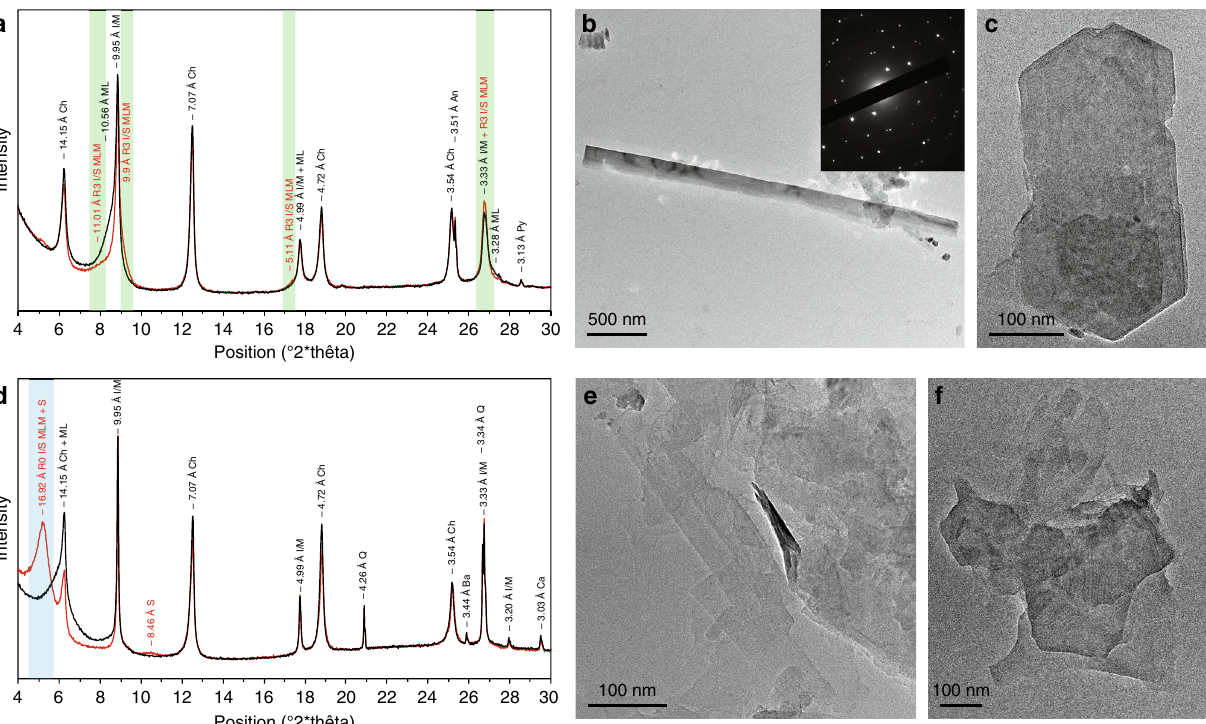
Fig. 5 Mineralogical composition of the <2 µ m clay-size fractions. X-ray diffraction pro fi les of oriented preparations after air-drying (black lines) and glycolation (red lines) and their transmission-electron images are given. a Microbial mat specimen. b Large, well-crystallized lath from microbial mat laminae. The inset shows selected area electron diffraction (SAED) pattern. hk 0 pattern shows a hexagonal structure typical of phyllosilicates and coherently stacked crystals. c Hexagonal habit of illite from a mat sample. d Associated sandstone sediment. e Lathlike and poorly crystallized particles from the host sandstone. f Tiny hexagonal-shaped particles from the host sediment. [Green areas correspond to long-range ordered illite – smectite mixed- layer minerals (R3 I/S MLM); Blue areas represent randomly ordered illite – smectite mixed-layer minerals (R0 I/S MLM); smectite (S); chlorite (Ch); mixed-layer (ML); illite/mica (I/M); anatase (An); quartz (Q); pyrite (Py); barite (Ba); calcite